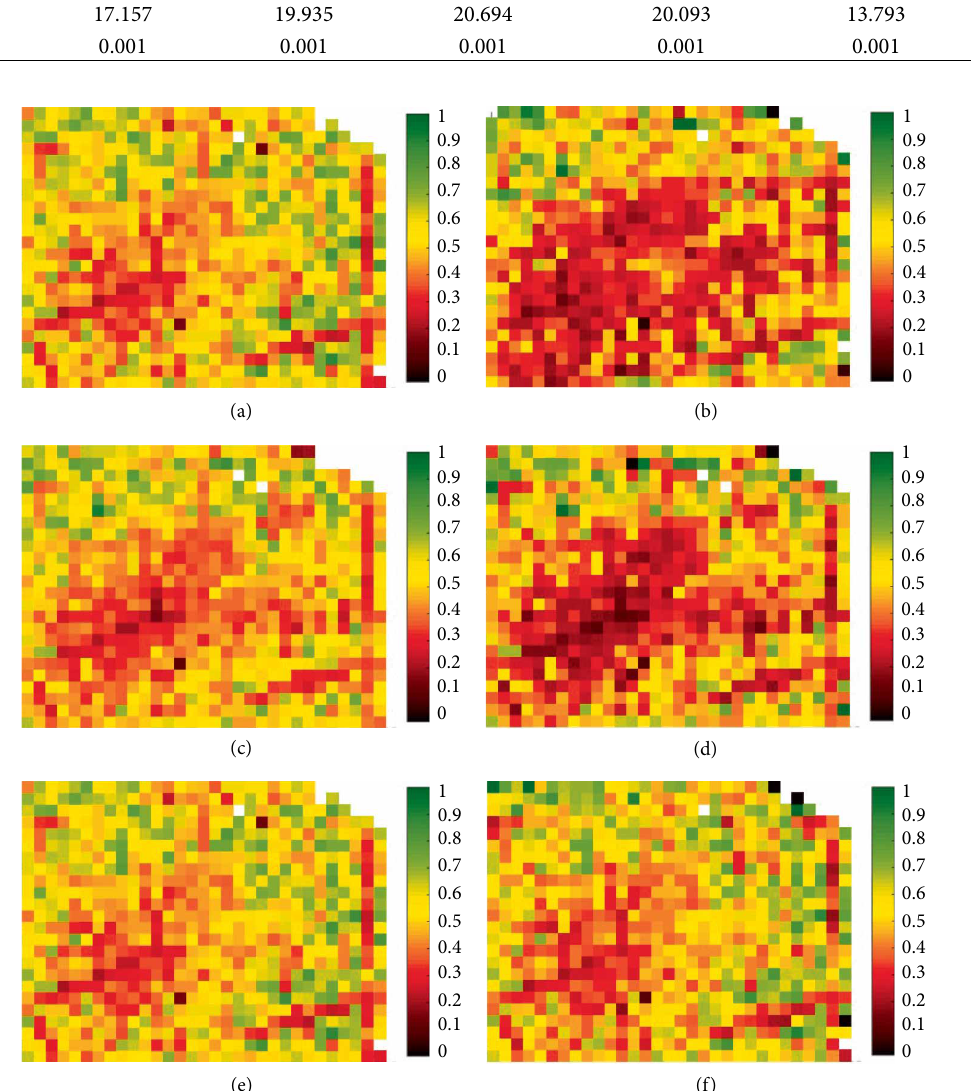
Figure 1: The distribution of mean RETTs during different time periods on nonrainy and rainy conditions respectively. The values during peak hours decrease significantly, while the difference during off-peak periods is not that significant. (a) Morning peak, nonrainfall. (b) Morning peak, rainfall. (c) Evening peak, nonrainfall. (d) Evening peak, rainfall. (e) Off peak, nonrainfall. (f) Off peak,